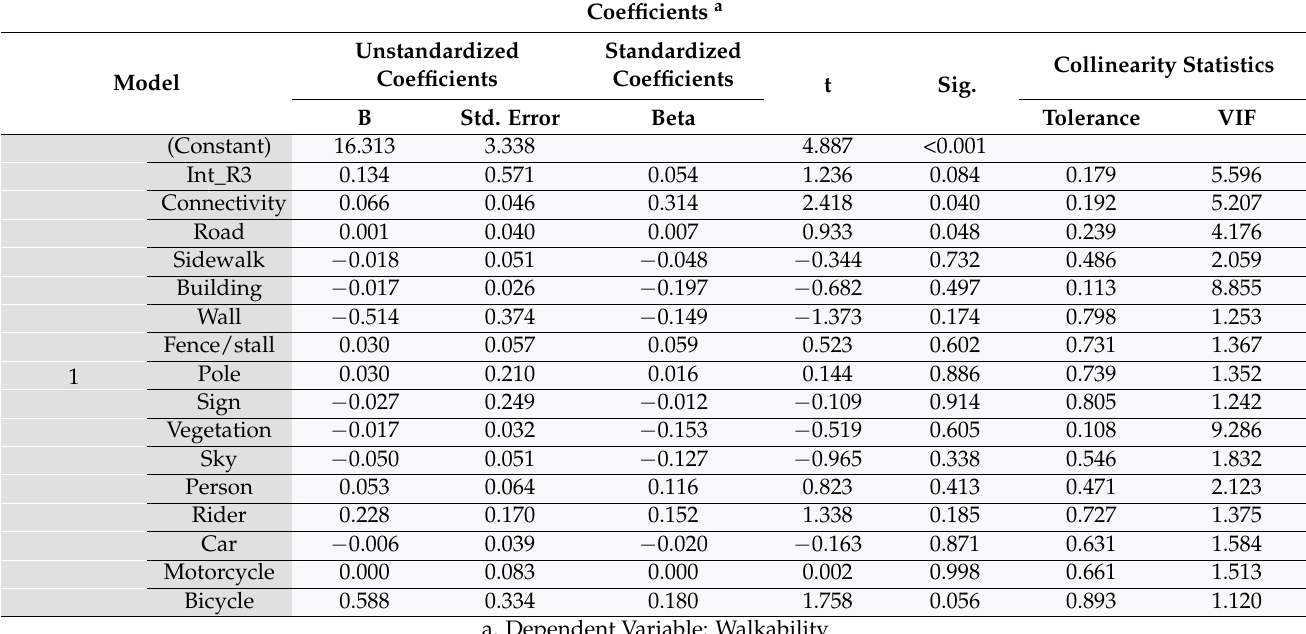
Table 7. Standard Partial Regression Coefficients (2022, after